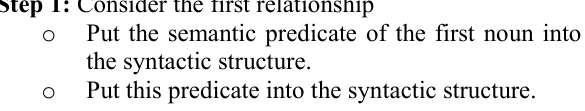
Algorithm 9 : Generate the syntactic structure of the new sentence for group